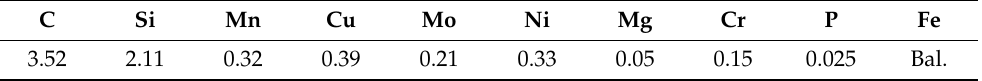
Table 1. Chemical composition (wt. %) of the Ductile Iron